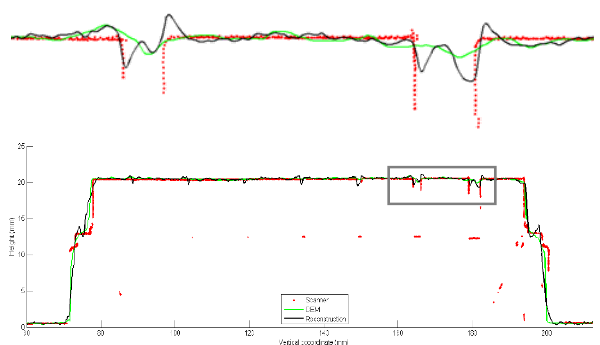
Figure 17. Elevation along a vertical section of the gap gauge in reconstructed height (black), compared with the DEM from the dense matcher (green) and the reference height from the laser scanner (red). The section in the rectangle is enlarged